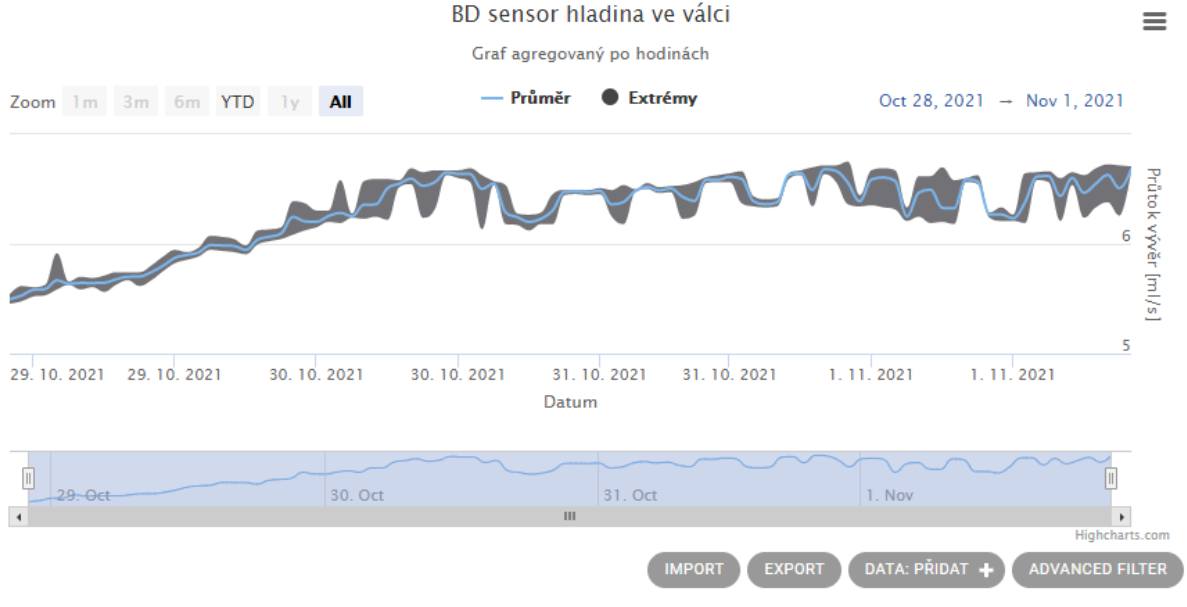
Fig. 14. An example of data presentation from the database web site – flow rate at V6, 1-hour average and min / max range in the same sampling. Table 1. An accuracy overview of various probes (adopted from technical